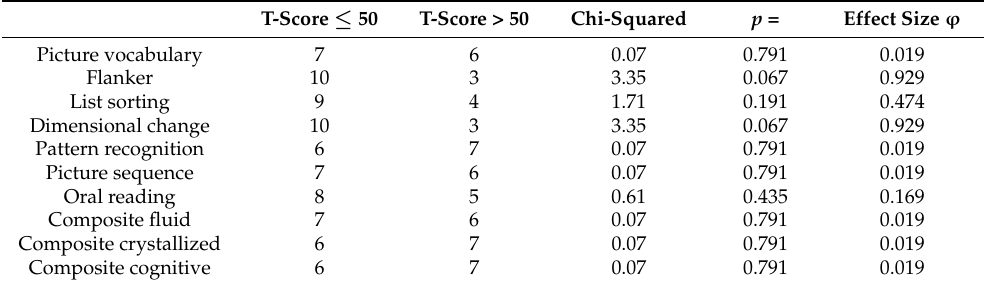
Table 2. Frequency of T-scores for all the tests in the NIH toolbox equal to or smaller than